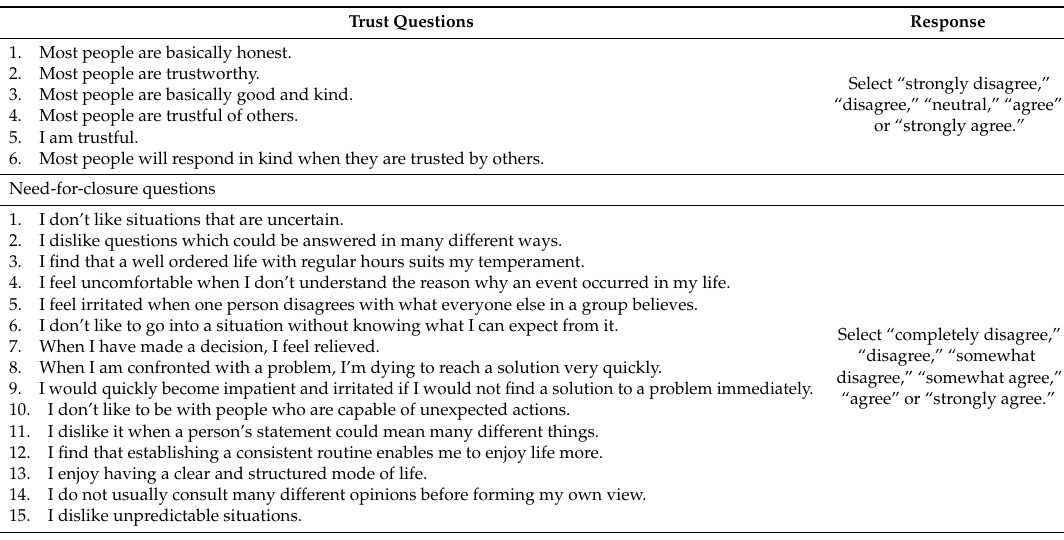
Table 3. Trust and need-for-closure